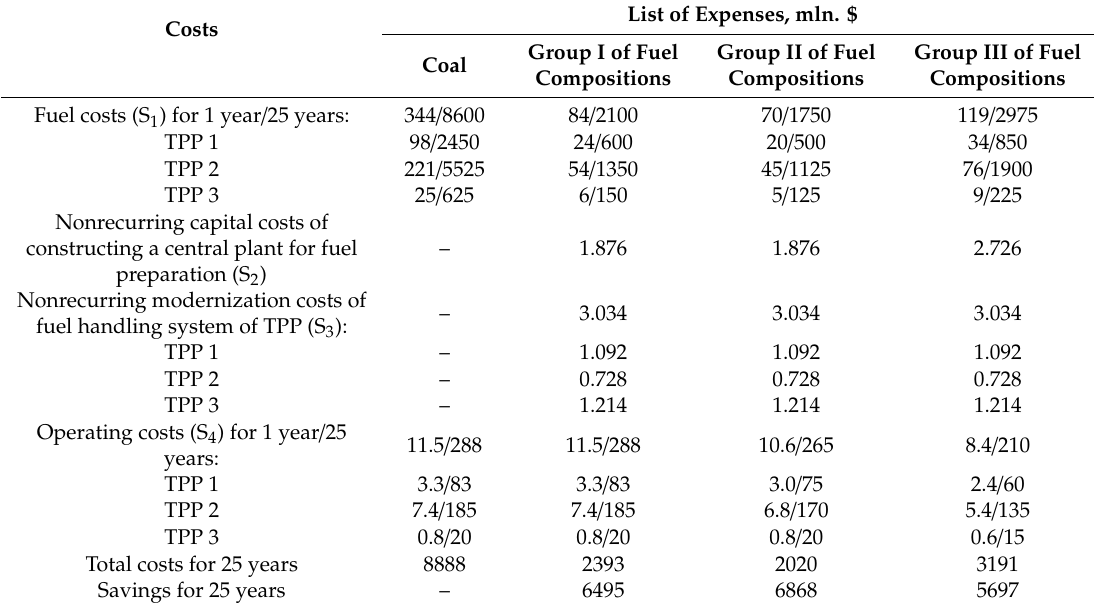
List of Expenses, mln.